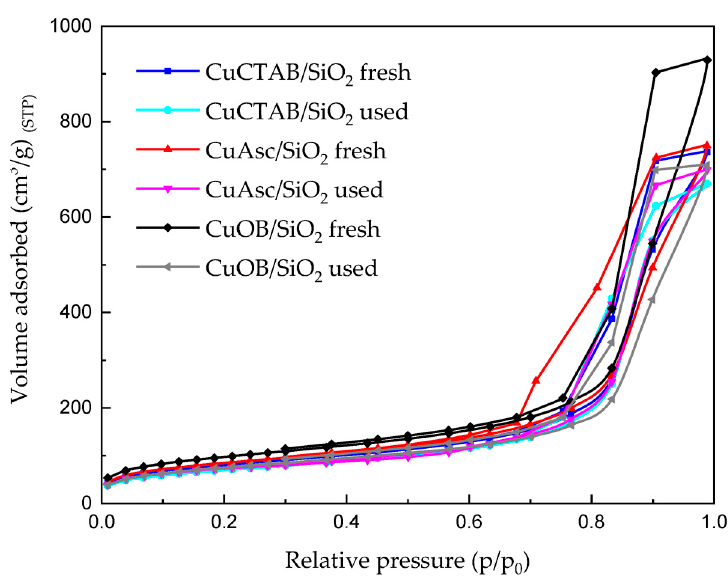
Figure 3. Nitrogen adsorption isotherms of the fresh and used catalysts.